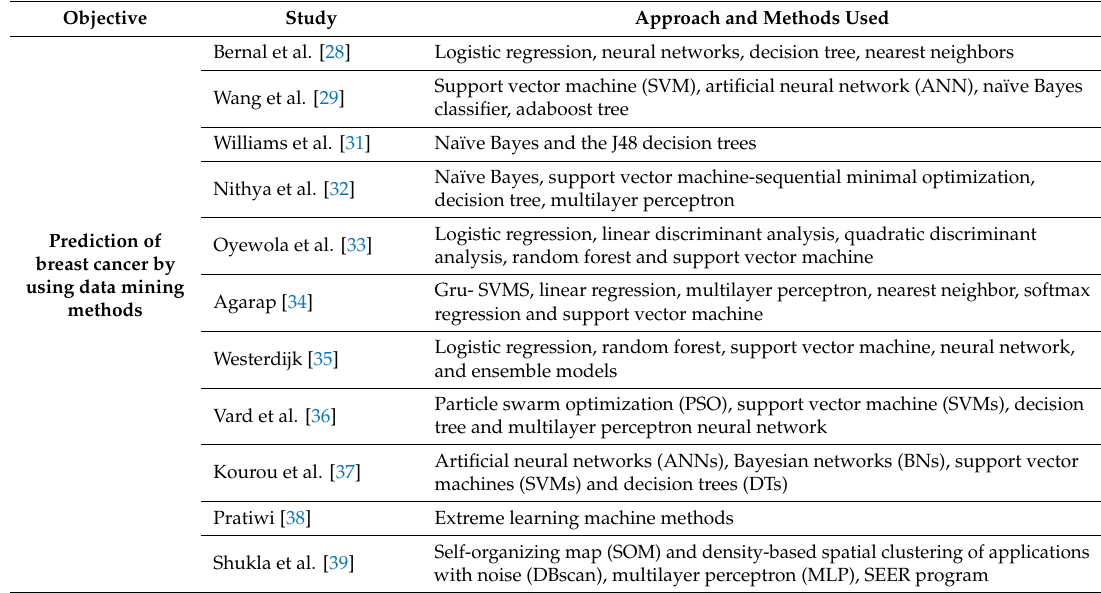
Figure 1 indicates the visualization of logistic regression steps.